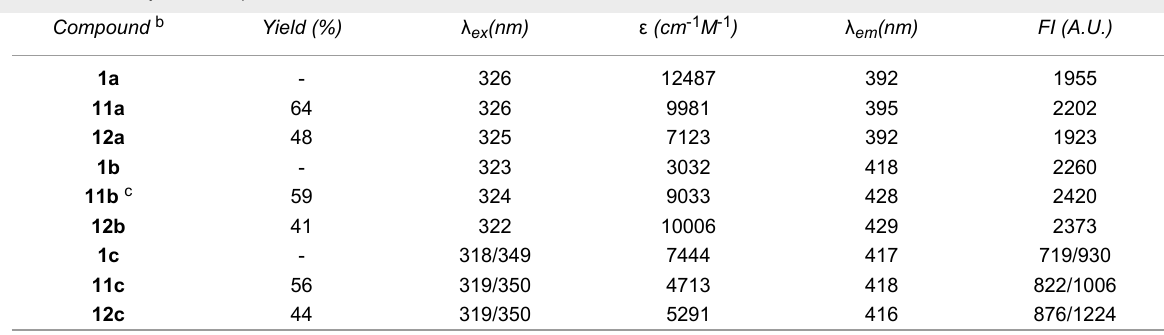
Table 1: Isolated yields and spectral characteristics of coumarin labeled nucleosides 11 – 12 a Compound